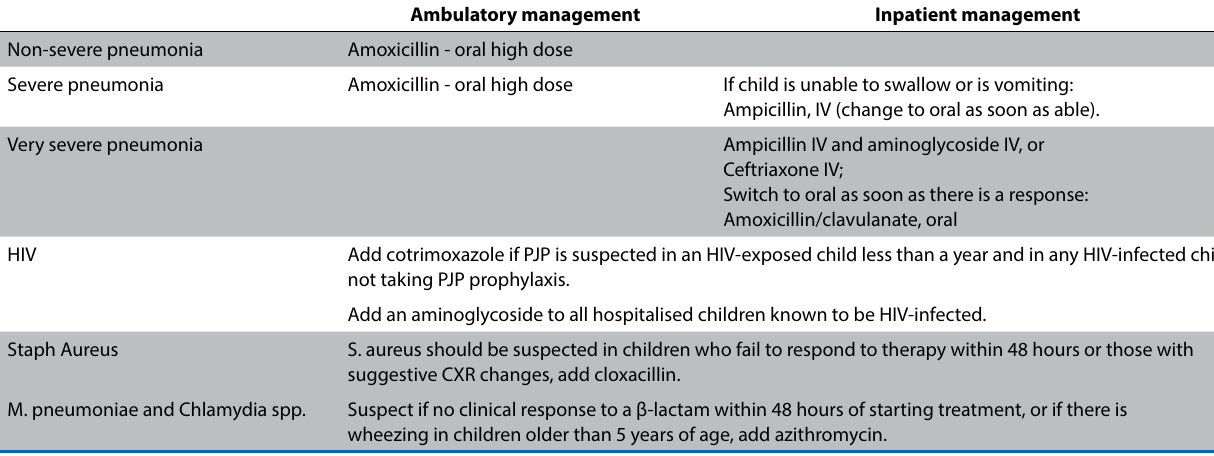
Table 2: Antibiotic choices for pneumonia in